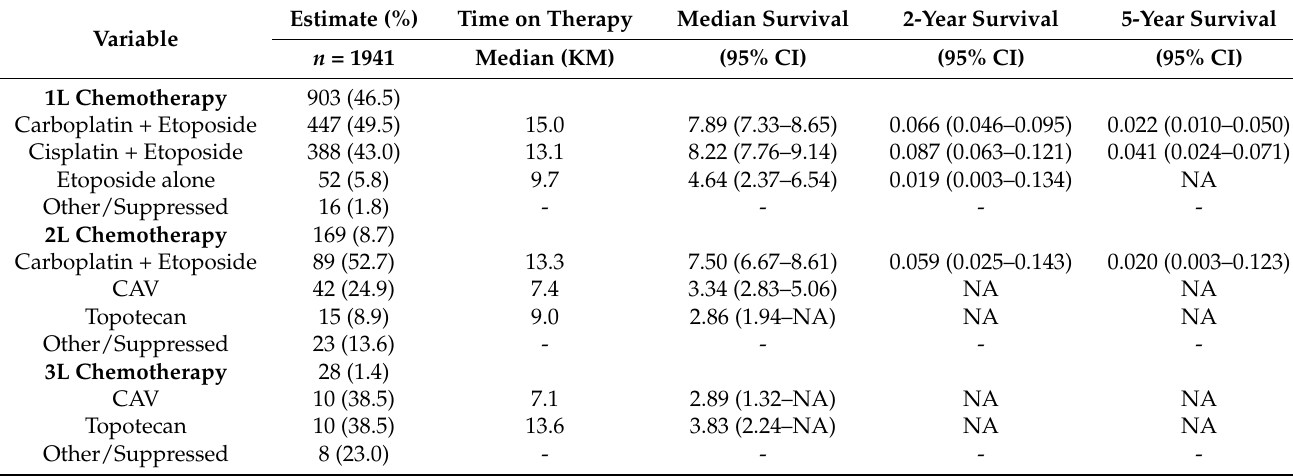
Table 2. Time on treatment and survival outcomes of ES-SCLC patients by treatment type and line of therapy.